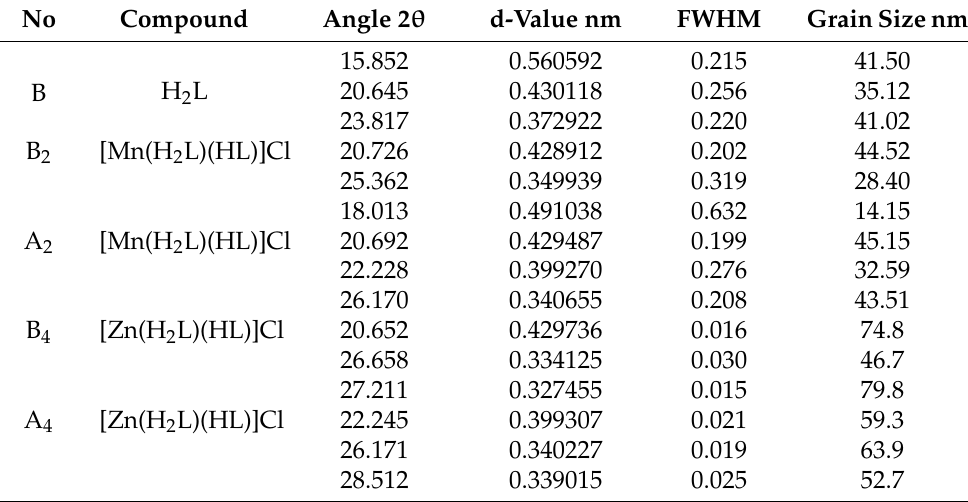
Figure 2. Electronic spectra of the synthesized Pb(II), Mn(II), Hg(II), and Zn(II) before (B, B 1, B 2, B 3, and B 4 ) and after (A, A 1, A 2, A 3, and A 4 ) γ -irradiation, respectively. Table 4. PXRD data of the ligand Mn(II) and Zn(II) complexes before and after